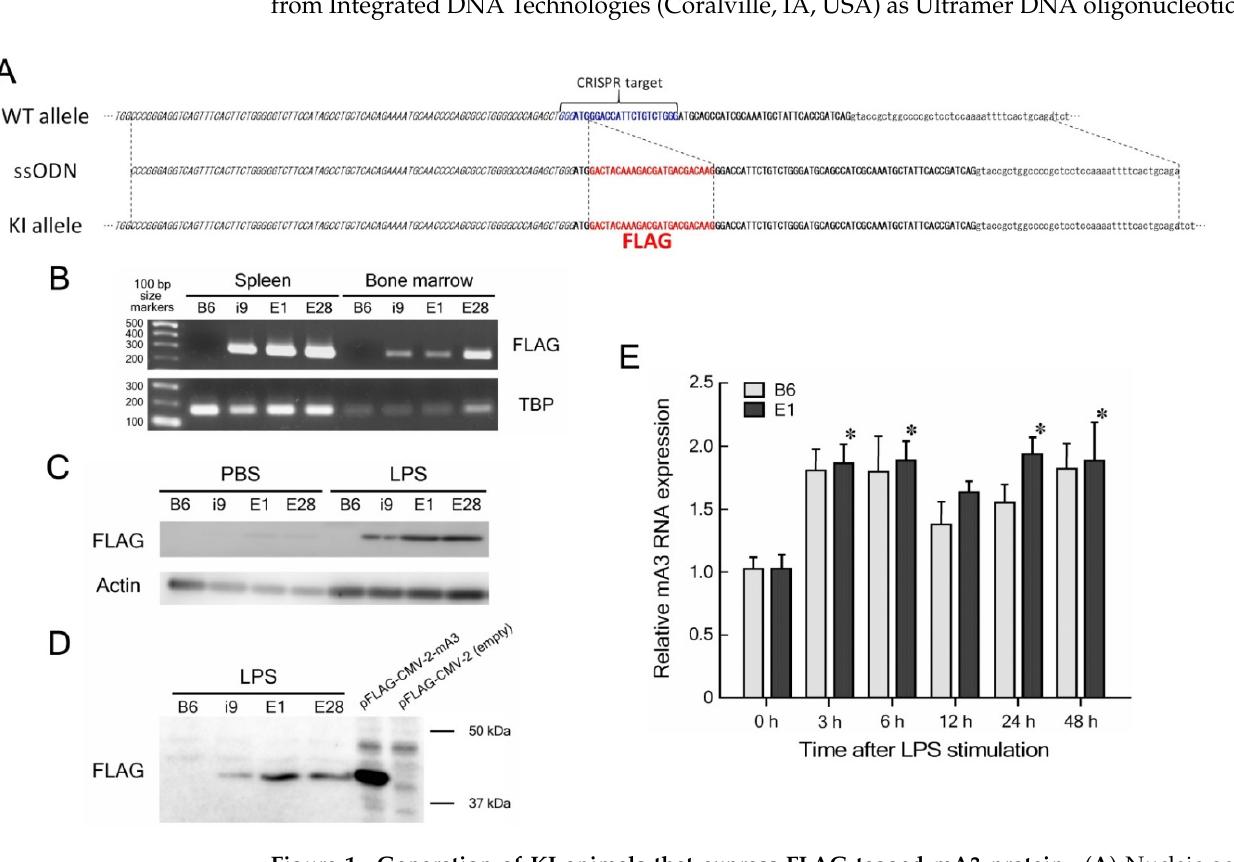
Figure 1. Generation of KI animals that express FLAG-tagged mA3 protein. ( A ) Nucleic acid sequences of the WT Apobec3 allele in B6 mice, ssODN, and KI allele intended to be generated by CRISPR-Cas-9-mediated genome editing. Exon 1 untranslated region (UTR) is italicized and coding sequence (CDS) in bold face. Intron 1 is shown in lower case. CRISPR target sequence is indicated by blue and FLAG sequence by red. For more details, see Figure S1. ( B ) RT-PCR detection of FLAG- tagged mA3 mRNA from spleen cells. TATA-binding protein (TBP) mRNA was detected as positive control. Pictures of the entire agarose gel are shown in Figure S2. Experiments were performed twice with essentially identical results. ( C ) Western blot assays detecting FLAG-tagged mA3 protein from cultured spleen cells. Spleen cells were cultured for 2 days either in the absence (PBS) or presence of LPS, and whole cell proteins were extracted with the lysis buffer and dissolved in SDS-PAGE